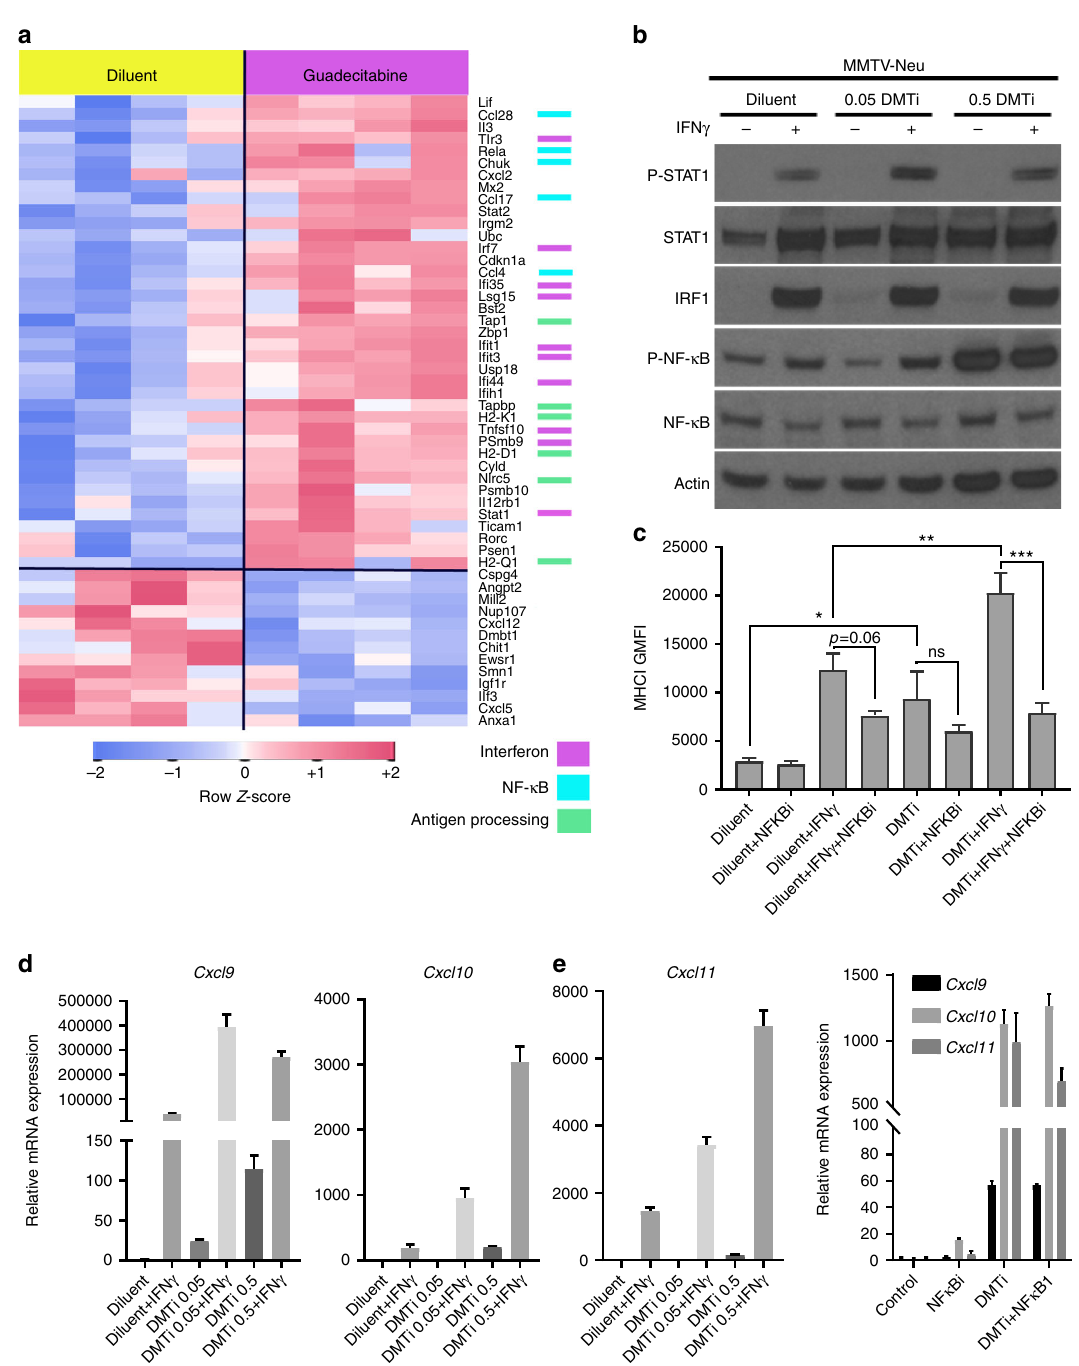
Fig. 4 Guadecitabine enhances IFN γ -mediated MHC-I expression and Cxcr3 ligands. a MMTV-neu tumors were resected 7 days after a 3-day in vivo treatment course with guadecitabine or diluent control. Tumor RNA was extracted and utilized for NanoString gene expression analysis using the PanCancer Immune Pathways codeset ( > 700 immune-related genes). Genes signi fi cantly altered (nominal p -value < 0.05) between the treatment groups are shown with a row-standardized z -scores in heatmap form. Association of altered genes with key pathways are color coded on the right. b MMTV-neu cells were cultured for 7 days with the indicated doses of guadecitabine, followed by 24 h treatment with IFN γ and evaluation by western blot analysis. c MMTV-neu cells were treated as in b but co-treated with or without BMS-345541 (during last 24 h, in tandem with IFN γ ) and assessed by fl ow cytometry for MHC-I. Data represent the mean of four experiment replicates ± SEM. * p < 0.05; ** p < 0.01; *** p < 0.001; ns nonsigni fi cant. d qRT-PCR for Cxcr3 ligands in MMTV-neu cells after 7 days of guadecitabine treatment at the indicated doses and 24 h treatment with IFN γ . Data represent the mean of 3 experiment replicates ± SEM. e Relative mRNA expression of Cxcr3 ligands in MMTV-neu cells after 7 days of treatment with guadecitabine (0.5 µ g/mL) or diluent control, and 24 h exposure to 10 µ M BMS-345541. Data represent the mean of 3 experiment replicates ±